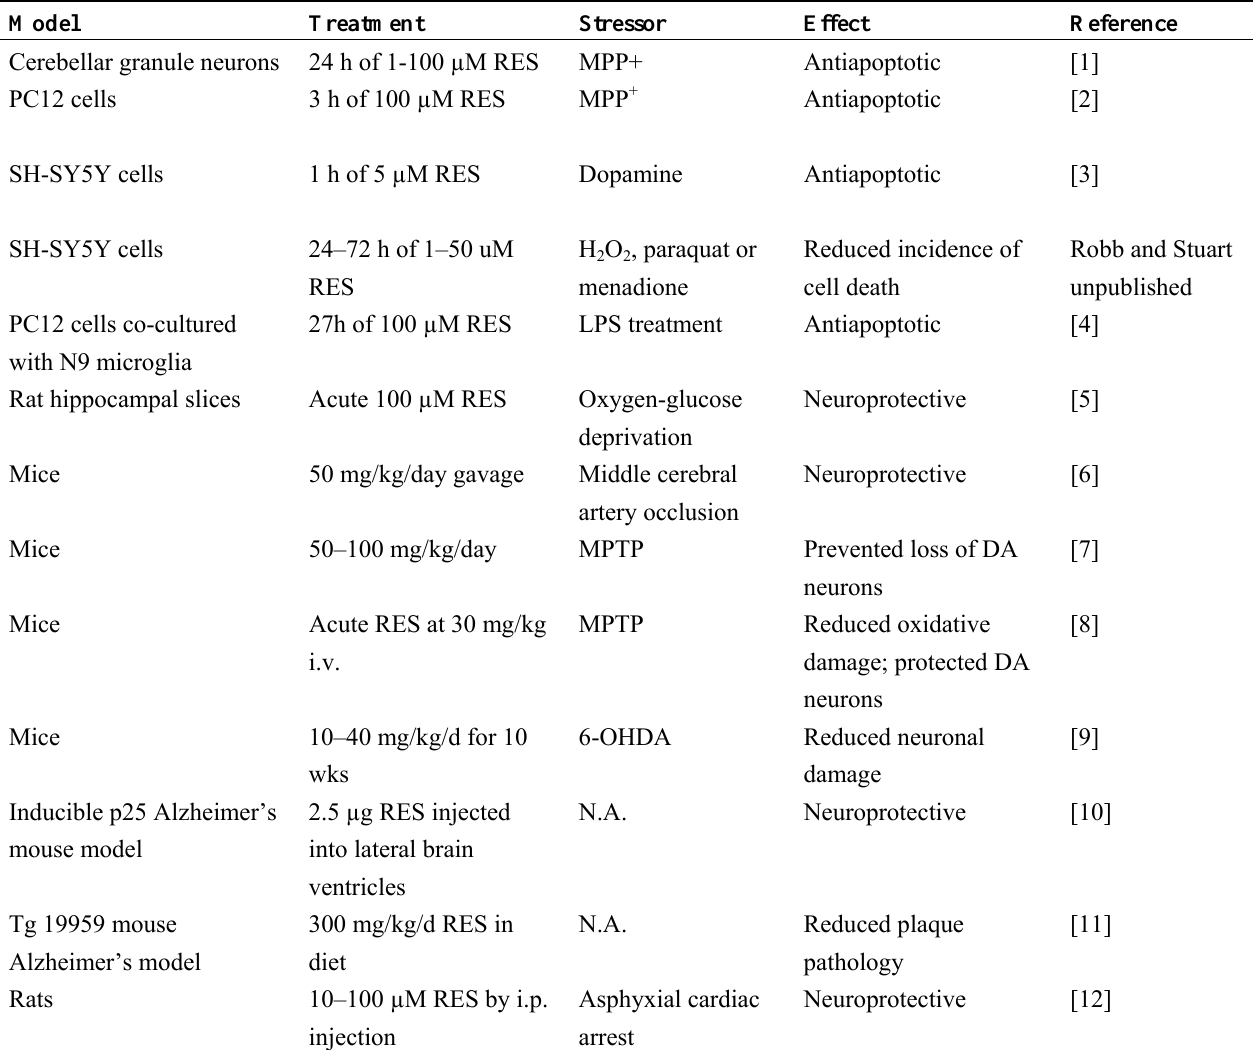
Table 1. Evidence for resveratrol as a